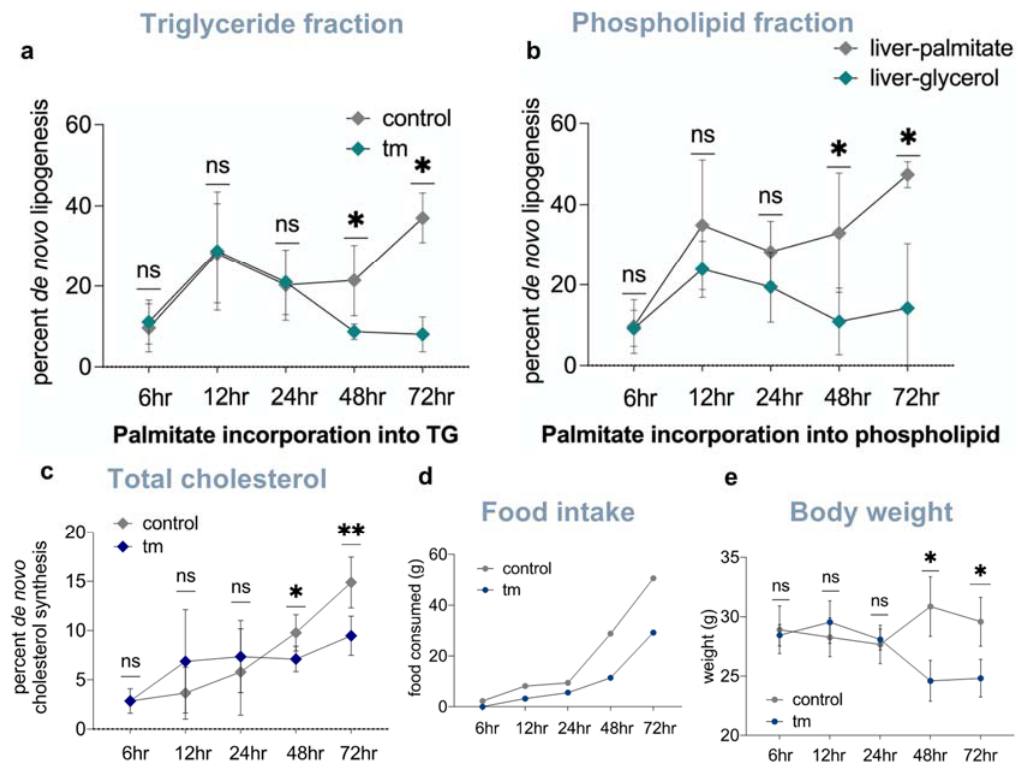
Figure 4. ( a ) De novo lipogenesis rates of palmitate incorporated into triglycerides in control and tunicamycin treated mice 12–72 h post treatment ( n = 5 per group). ( b ) De novo lipogenesis rates of palmitate incorporated into phospholipids in control and tunicamycin treated mice 12–72 h post treatment ( n = 5 per group). ( c ) De novo cholesterol synthesis (free and esterified) rates in control and tunicamycin treated mice 12–72 h post treatment ( n = 5 per group). ( d ) Food intake in control and tunicamycin treated mice 12–72 h post treatment ( n = 5 per group). ( e ) Average body weight of control and tunicamycin treated mice 12–72 h post treatment ( n = 5 per group). ns = no significance,